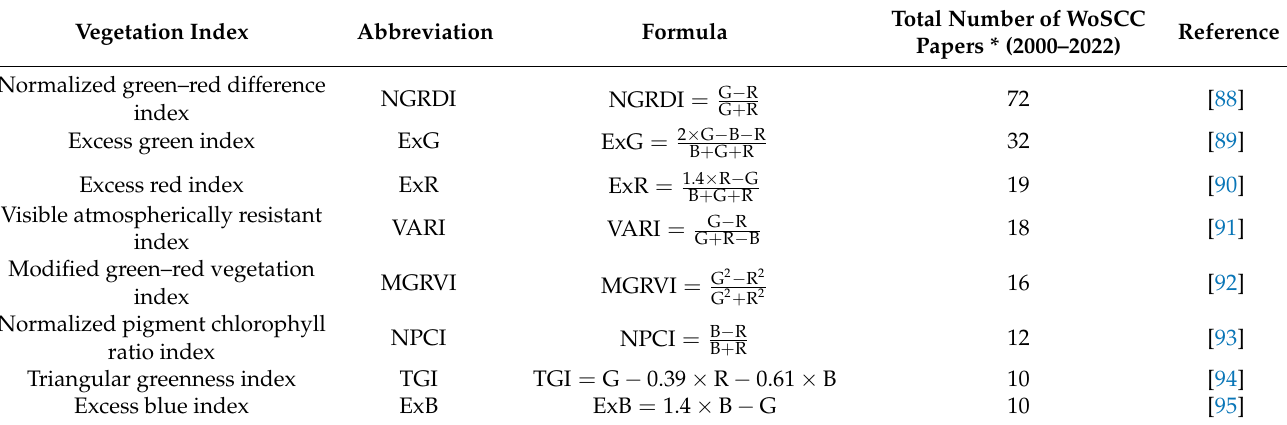
Table 2. Eight major vegetation indices based on RGB sensors with the highest total number of appearances in WoSCC papers since